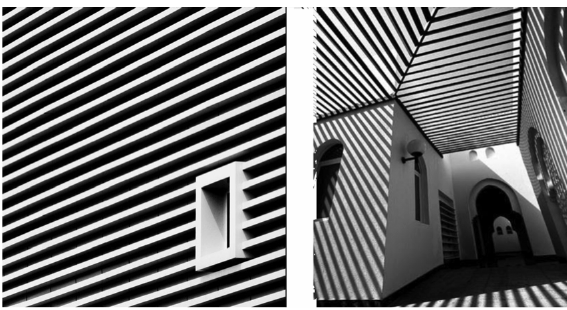
Figure 4. Stripes in the contemporary urban environment